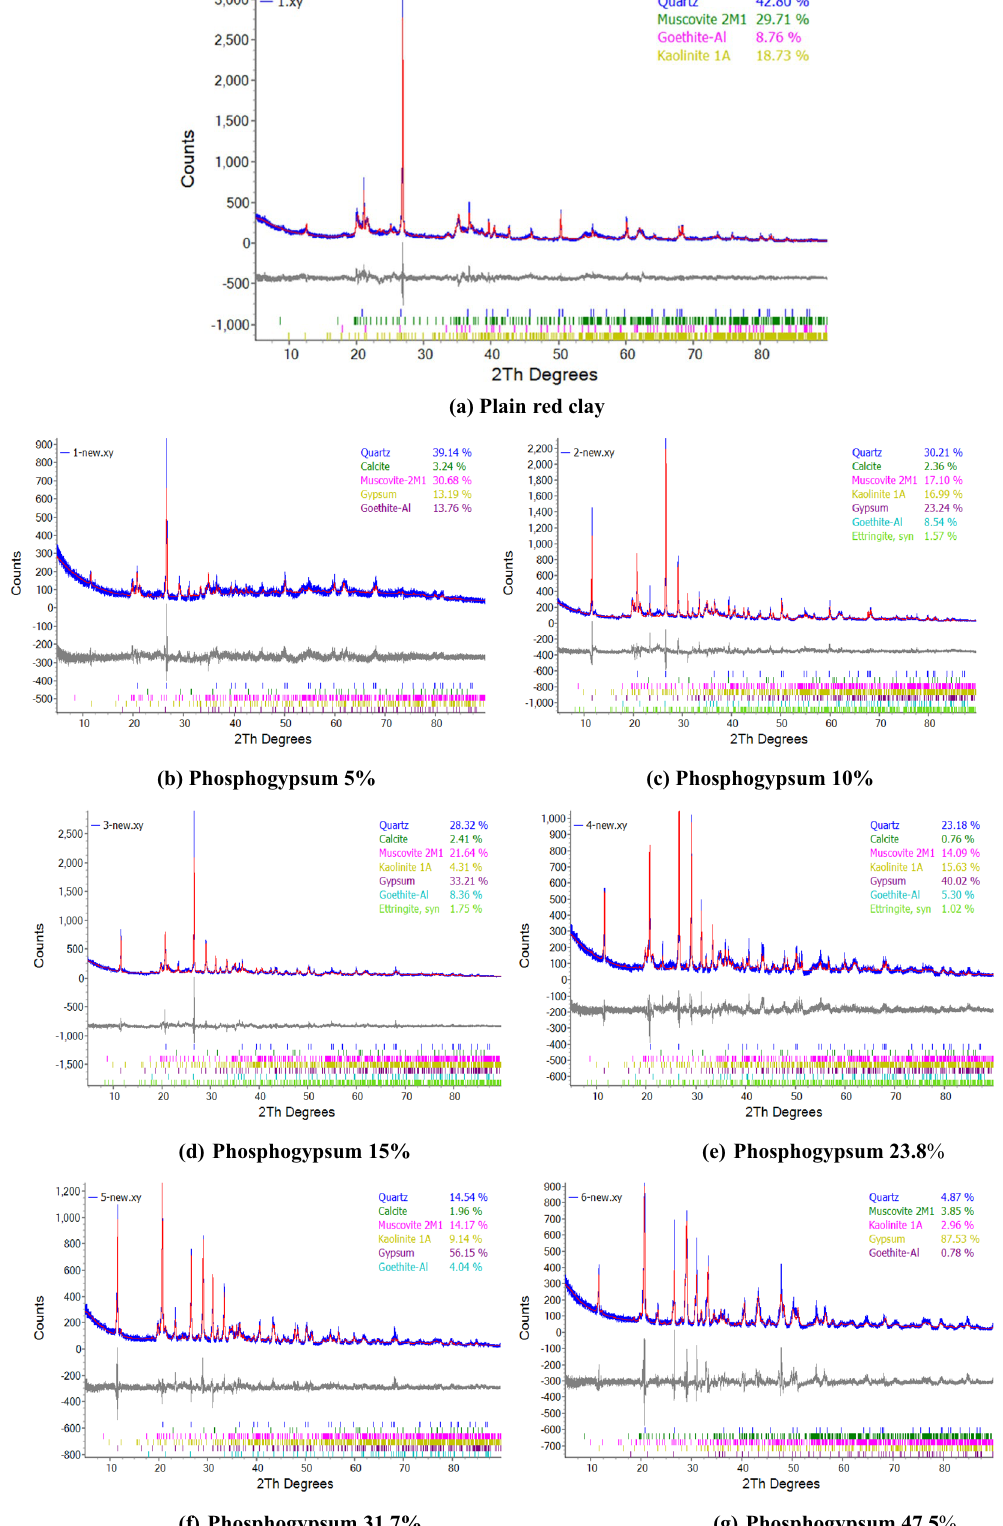
Fig. 14 Quantitative analysis of compound composition of